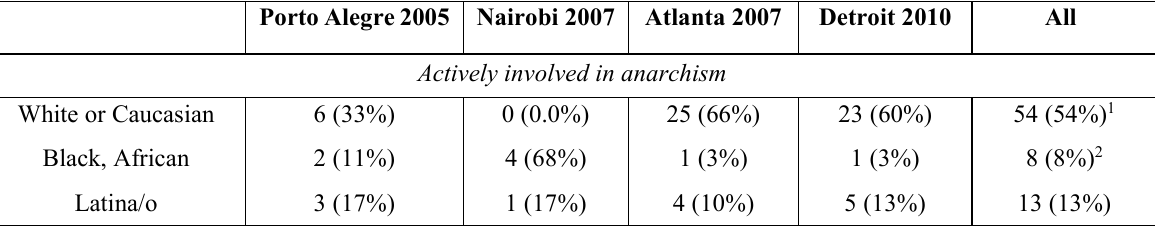
Table 3: Racial/ethnic Composition of Anarchists at the Social Forums Porto Alegre 2005 Nairobi 2007 Atlanta 2007 Detroit 2010 All Actively involved in anarchism White or Caucasian 6 (33%) Black,